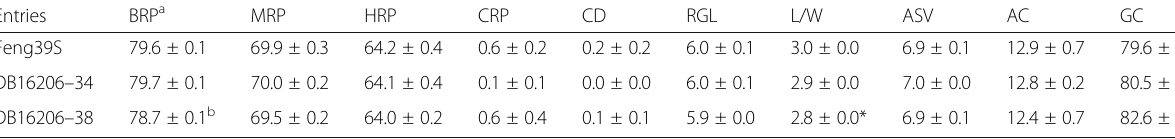
Table 6 The rice quality performance of selected PTGMS lines and recurrent parent Feng39S Entries BRP a MRP HRP CRP